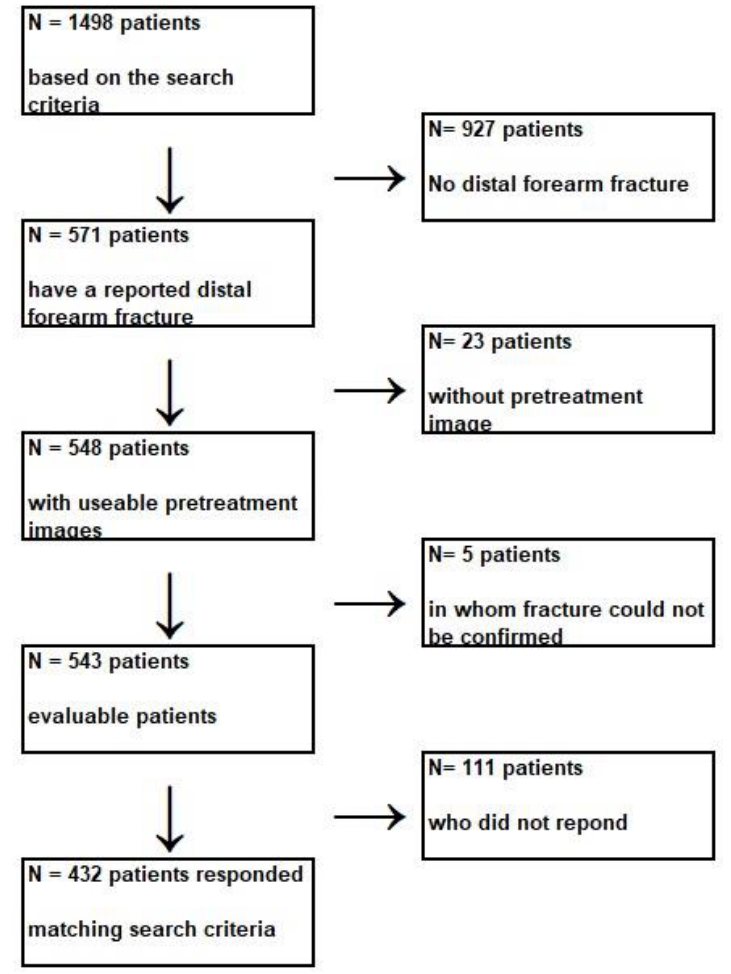
Figure 1. STROBE Participant Flow Chart.